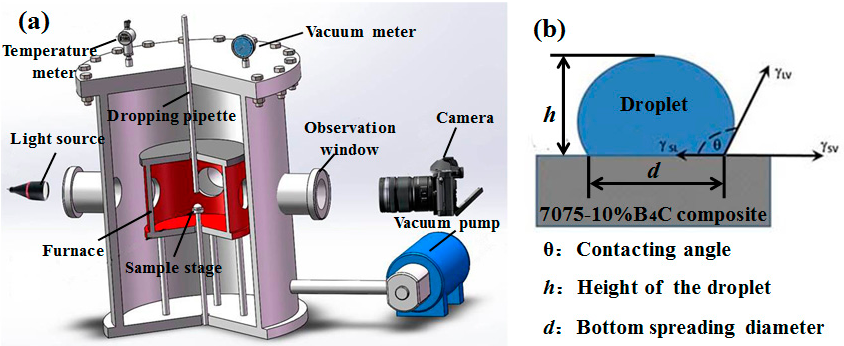
Figure 1. Schematic diagram of ( a ) the sessile drop experiment equipment and ( b ) the droplet–substrate contacting condition.